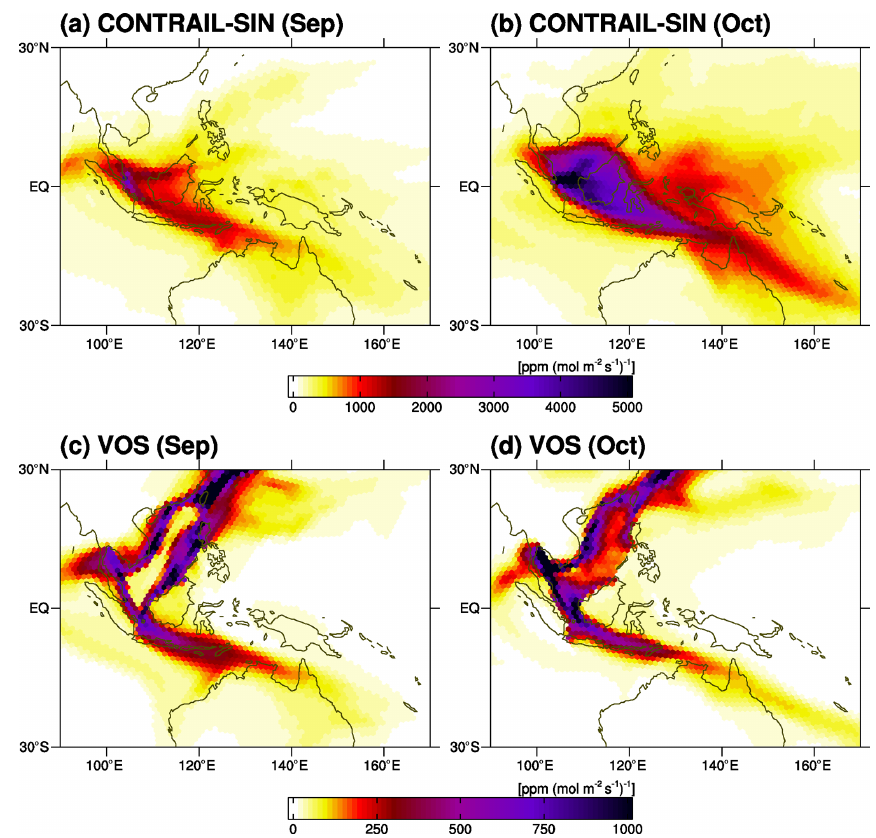
Figure 7. Sensitivity of surface CO 2 flux against the observations (e.g. footprints) of CONTRAIL over Singapore (a, b) and NIES VOS (c, d) for September (a, c) and October (b, d) 2015.